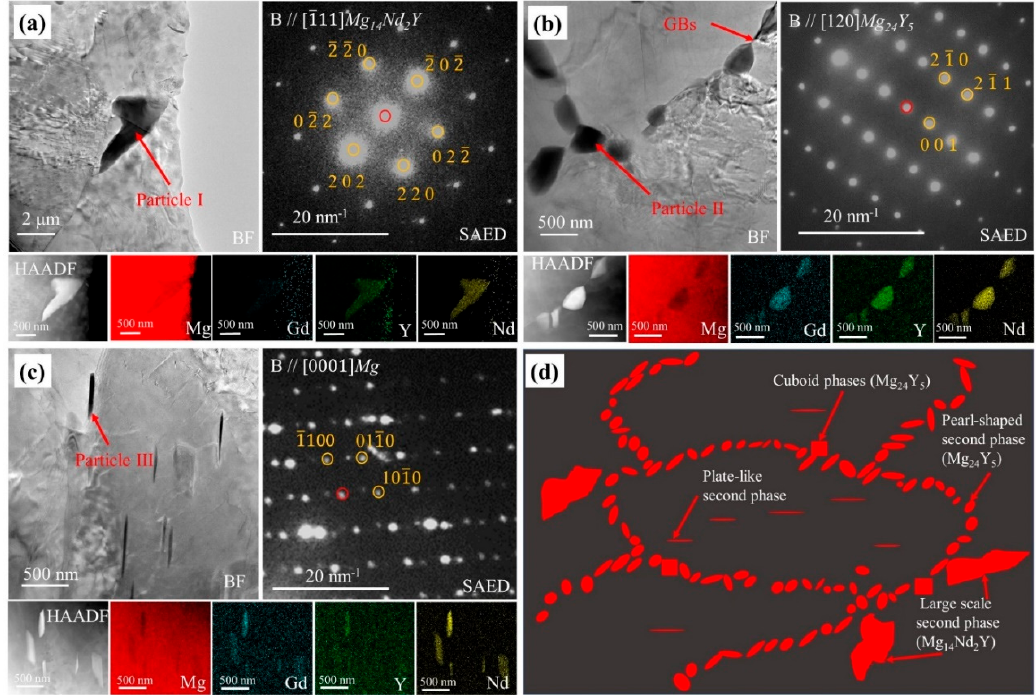
Figure 4. TEM bright–field images and corresponding SAED patterns, HAADF–STEM image and corresponding EDS elemental mappings, and schematic diagram of forged WE43 alloy: ( a ) Particle I in forged WE43 alloy; ( b ) Particle II in forged WE43 alloy; ( c ) Particle III in forged WE43 alloy; ( d ) schematic diagram of forged WE43 alloy.